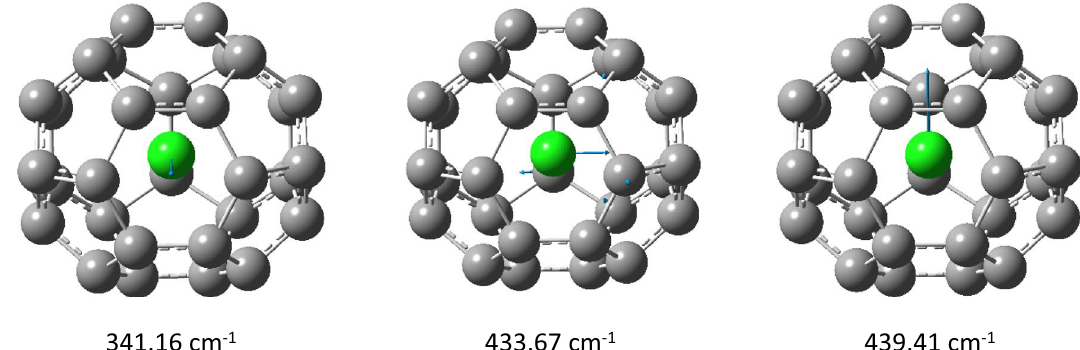
Figure 3. Displacement vectors of the three most isotope-sensitive vibrations.